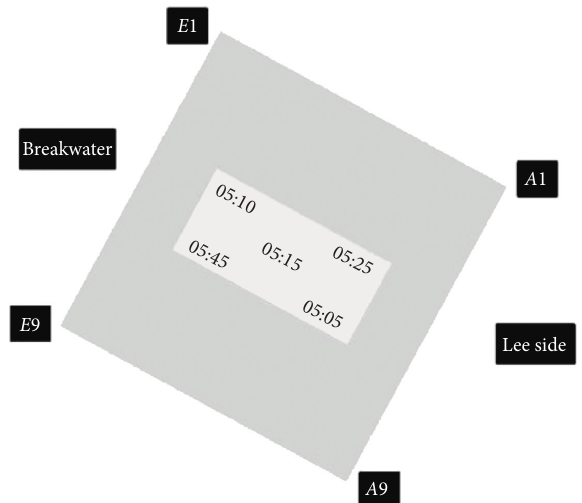
Figure 26: The sinking time of the first-stage piling in the range of caisson R5-8 in